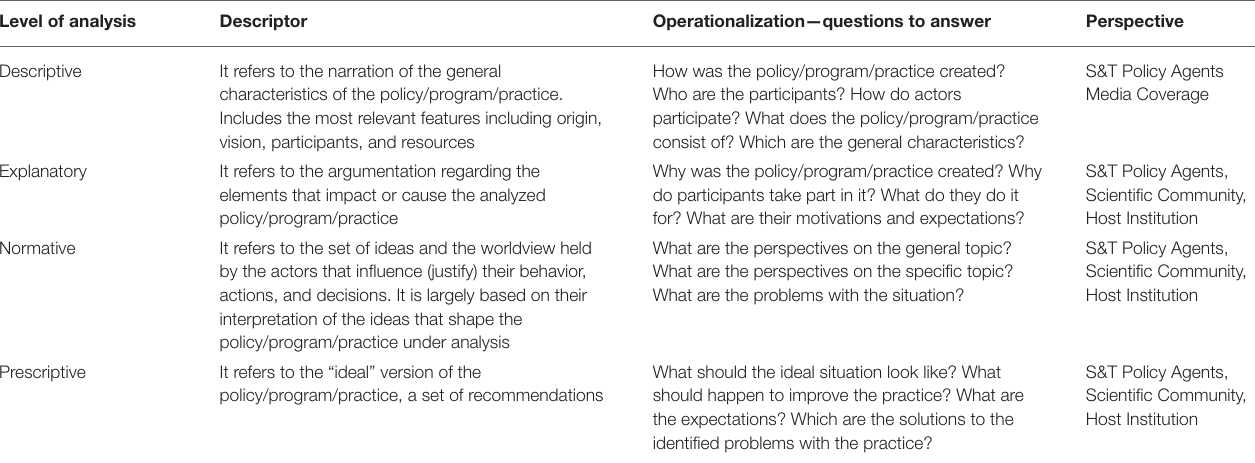
TABLE 5 | Levels of analysis, Converciencia : policy and practice